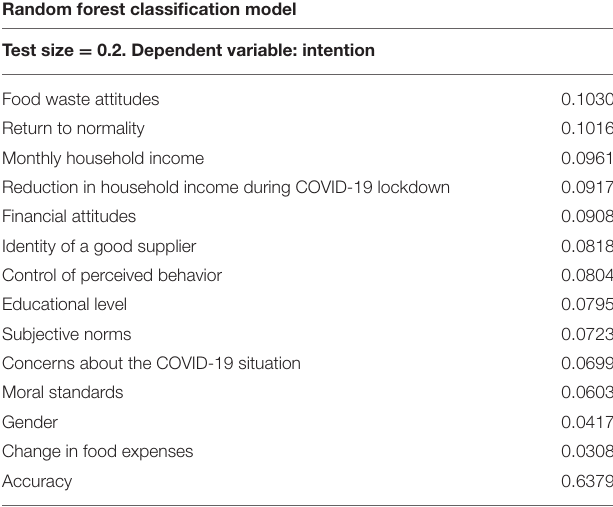
TABLE 3 | Random Forest classification model for the variable intention to not waste food . Random forest classification model